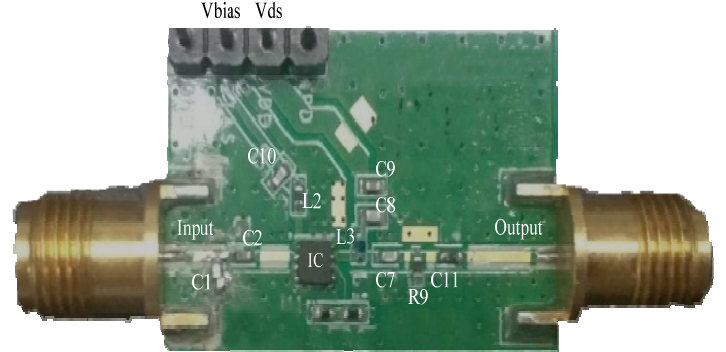
Figure 1. The circuit schematic of the LNA.